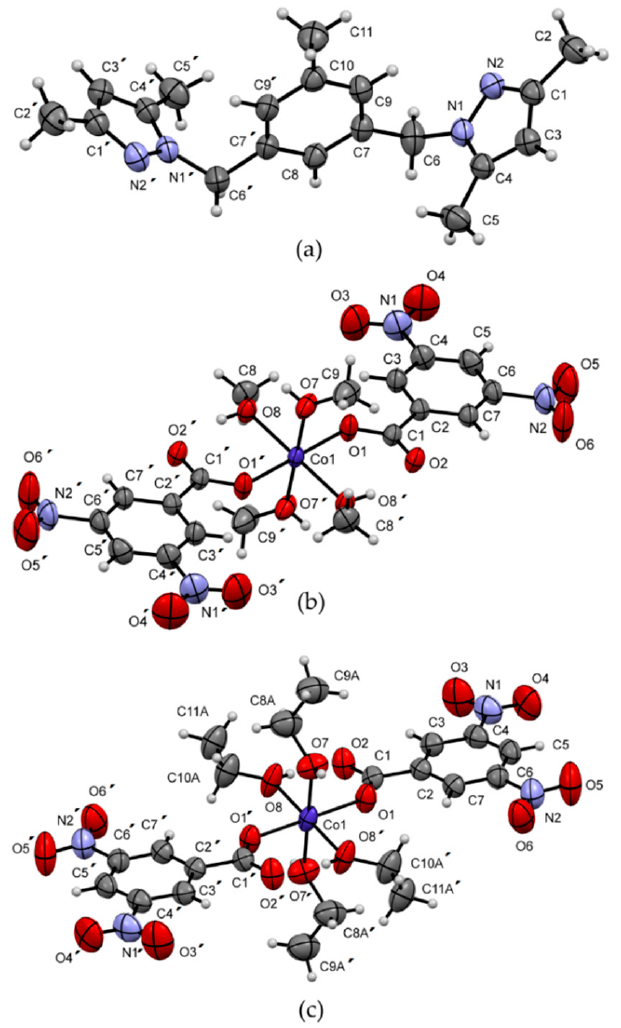
Figure 5. Molecular structures of ( a ) L5 and complex 1 recrystallized in ( b ) methanol and ( c ) acetone: ethanol, showing anisotropic displacement ellipsoids drawn at the 50% probability level. H atoms are shown as small spheres of arbitrary radii. Selected bond lengths (Å) for ( b ): Co(1)-O(1) 2.0671(14), Co(1)-O(7) 2.0710(15), Co(1)-O(8) 2.1119(13) and ( c ): Co(1)-O(1) 2.0612(18), Co(1)-O(7) 2.098(2), Co(1)-O(8) 2.086(2). Selected bond angles ( ◦ ) for ( b ): O(1)-Co(1)-O(7) 88.77(6), O(1)-Co(1)-O(8) 90.75(5) and for ( c ): O(1)-Co(1)-O(7) 90.40(8), O(1)-Co(1)-O(8)